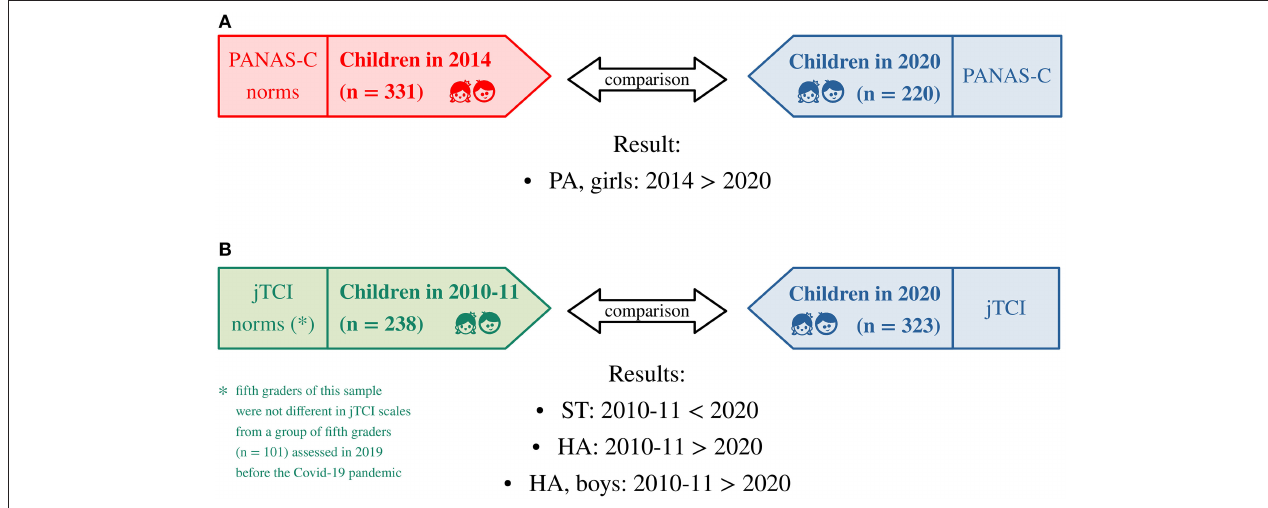
FIGURE 1 | Primary analyses of the study. (A) Comparison of PANAS-C scores collected during the pandemic with normative PANAS-C scores collected in 2014 (75) (the normative sample included fourth and fifth graders’ data and, therefore, only data of fourth and fifth graders assessed in 2020 were included in the analysis). (B) Comparison of jTCI scores collected during the pandemic with normative jTCI scores collected in 2010–11 (77). PANAS-C, Positive And Negative Affect Scale for Children; PA, Positive Affect; jTCI, junior Temperament and Character Inventory; HA, Harm Avoidance; ST, Self-Transcendence.